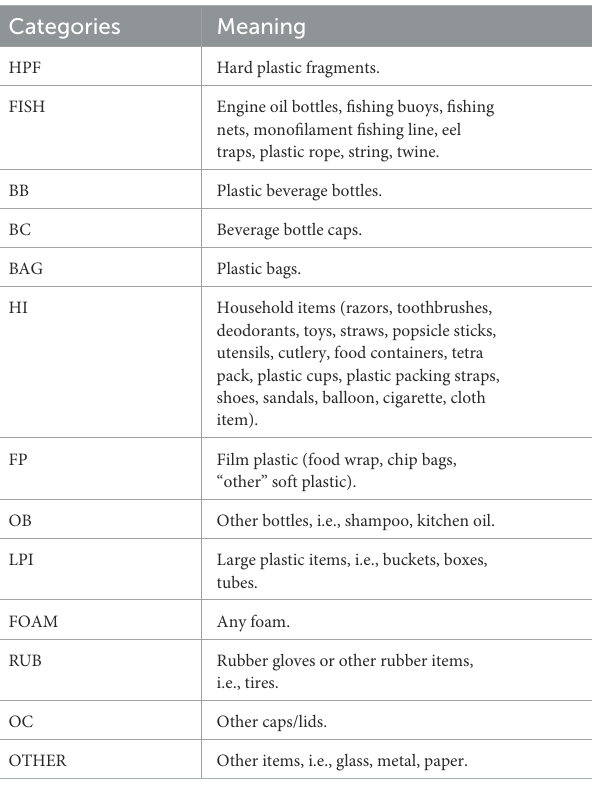
TABLE 1 Macroplastic categories adapted for the Galápagos study using the CSIRO protocol (Schuyler et al.,